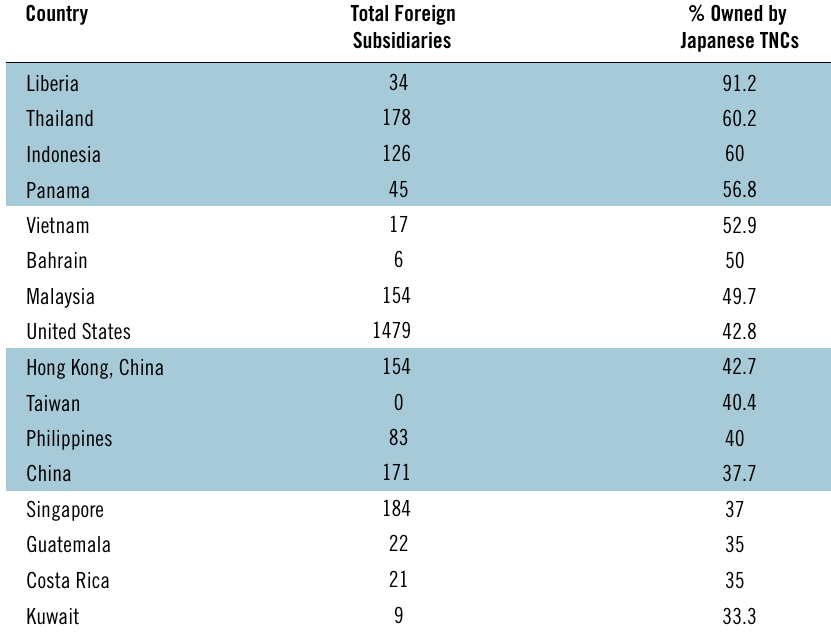
Figure 5 – Location of TNC Subsidiaries